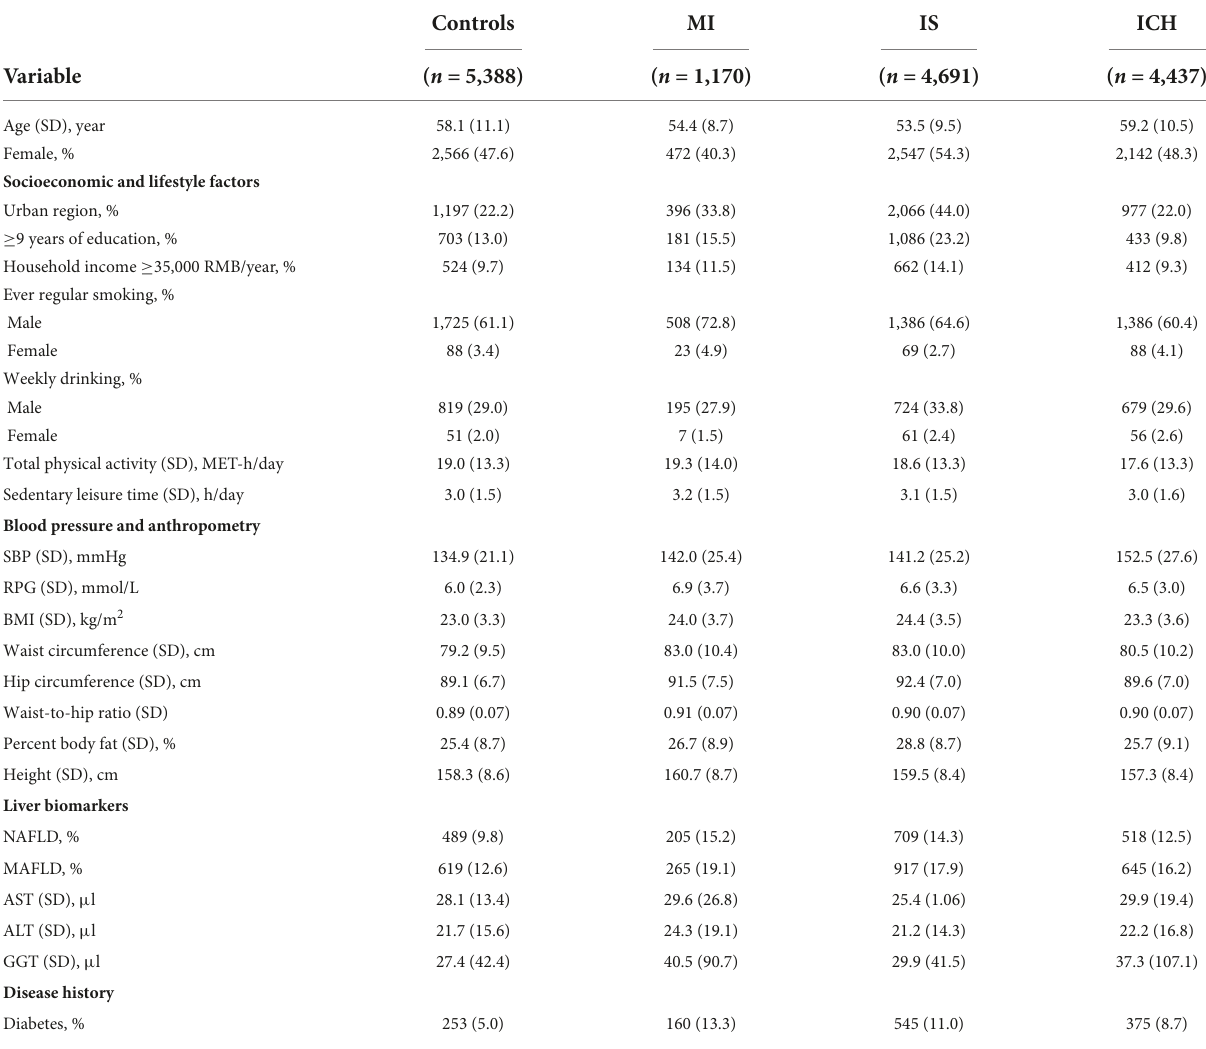
TABLE 1 Baseline characteristics of participants by incident disease status.